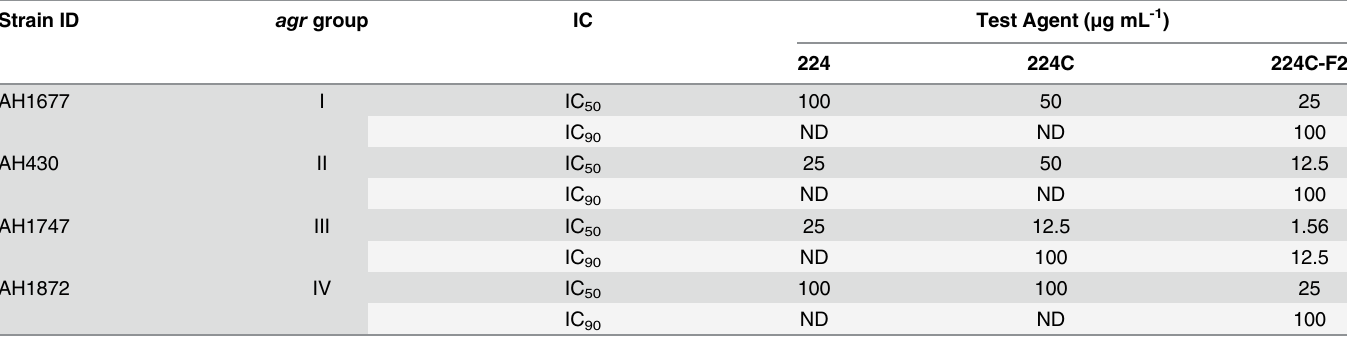
Table 3. Inhibition of S . aureus quorum sensing by Castanea sativa leaf extracts as detected by agr reporter strains. All tests were performed at sub-MIC 50 concentrations to avoid data skewing from potential growth inhibition effects. All IC values are represented in μ g mL -1